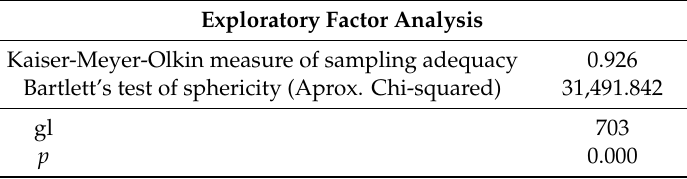
Table 2. Kaiser, Meyer and Olkin (KMO) and Bartlett